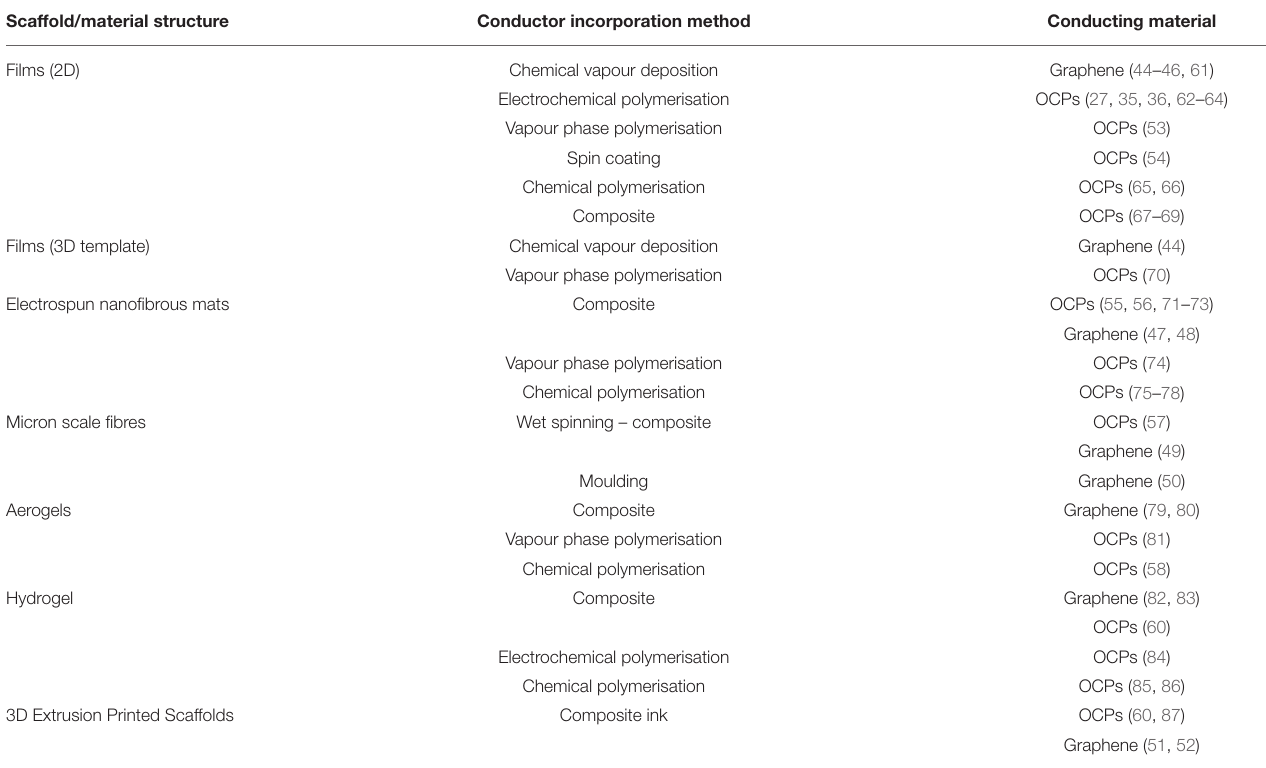
TABLE 1 | Commonly used fabrication approaches for biomaterials incorporating OCPs and